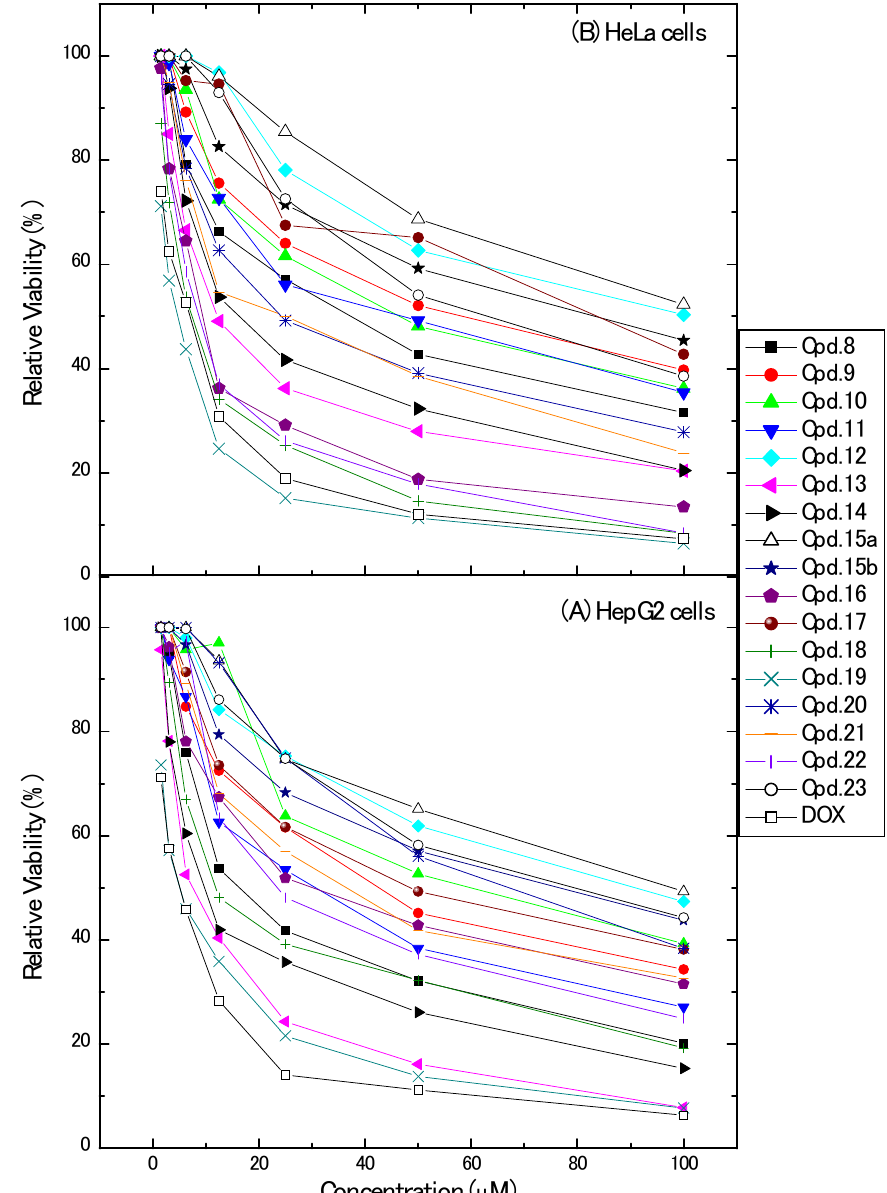
Figure 4. Relative viabilities of HepG2 and HeLa cells as affected by different synthesized compounds.